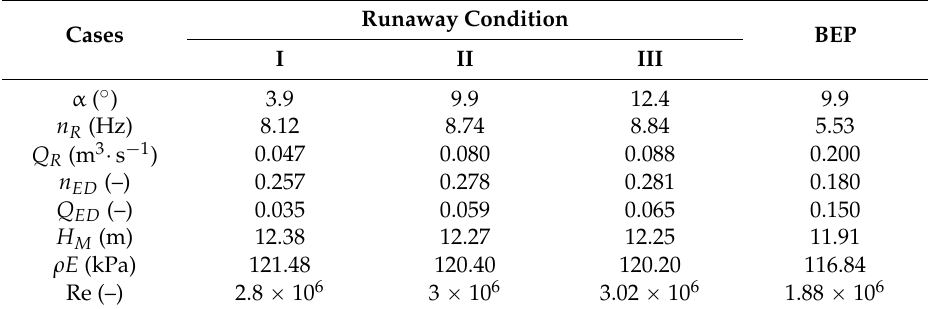
Table 2. Operating parameters and specific hydraulic energy ( ρ E ) for runaway and BEP operating conditions. Runaway Cases